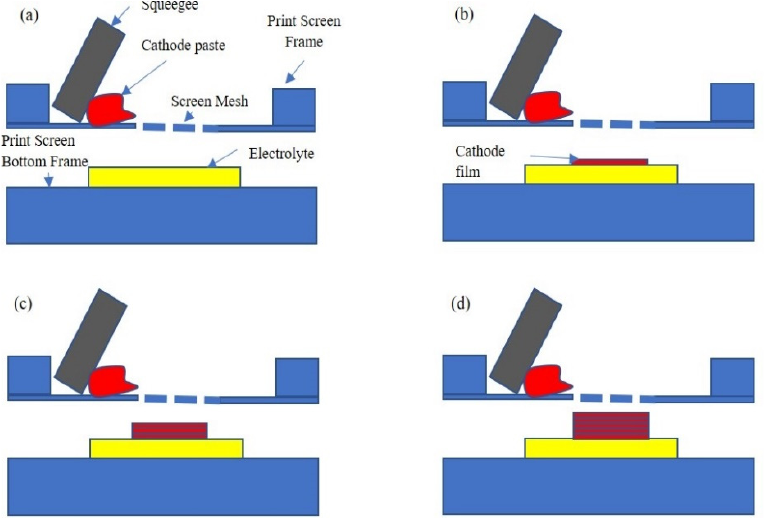
Figure 5. Illustration of the print screen with manually applied load. ( a ) Overall setup for the cathode film printing, ( b ) 1× printing, (c ) 3× printing, and ( d ) 5× printing.